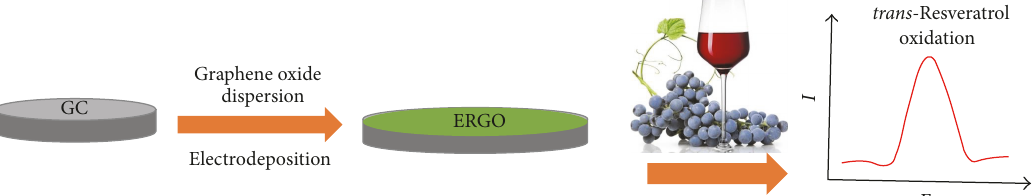
in 0.1 M KCl from 0.1 MHz to 0.1 Hz at ac amplitude of 5 mV under open-circuit potential conditions, obtained at the GC (1) and